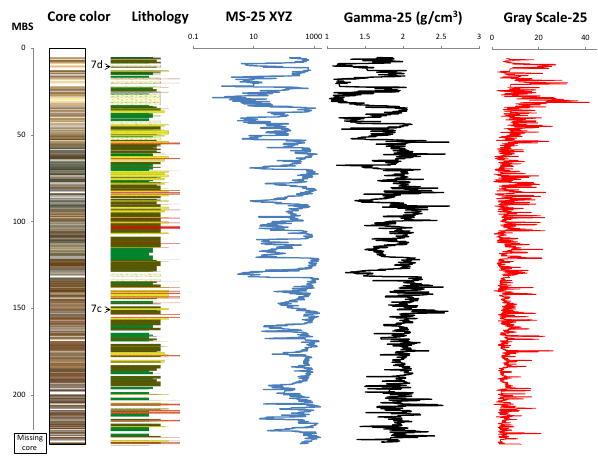
Figure 9. Summary stratigraphy of core HSPDP-WTK13-1A, from the West Turkana drilling area, northern Kenyan Rift Valley, based on initial core description results. Columns from left to right: core color stratigraphy; lithologic log; see Fig. 5 for the key to litholo- gies used in all cores illustrated; composite of magnetic susceptibil- ity (MS) log data (25-point running mean smooth) from LacCore Geotek © XYZ point sensor data; composite of induced gamma density log data (25-point running mean smooth, spurious val- ues <1.4gmcm − 3 removed); and composite of spectrophotomet- ric grey-scale log data (25-point running mean smooth). All data collection, instrumentation and parameters as in Fig. 5.